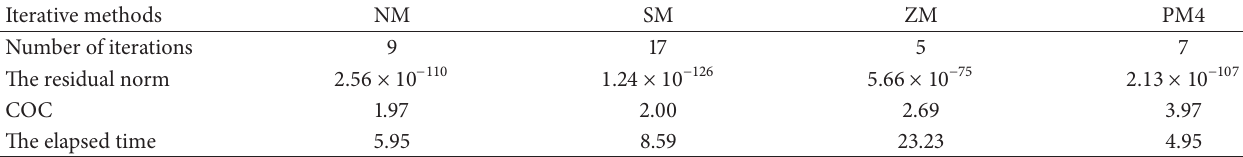
Table 3: Results of comparisons for different methods in Test 3 using x (0) = (2, ...,2) and 𝑁 = 200 . Iterative